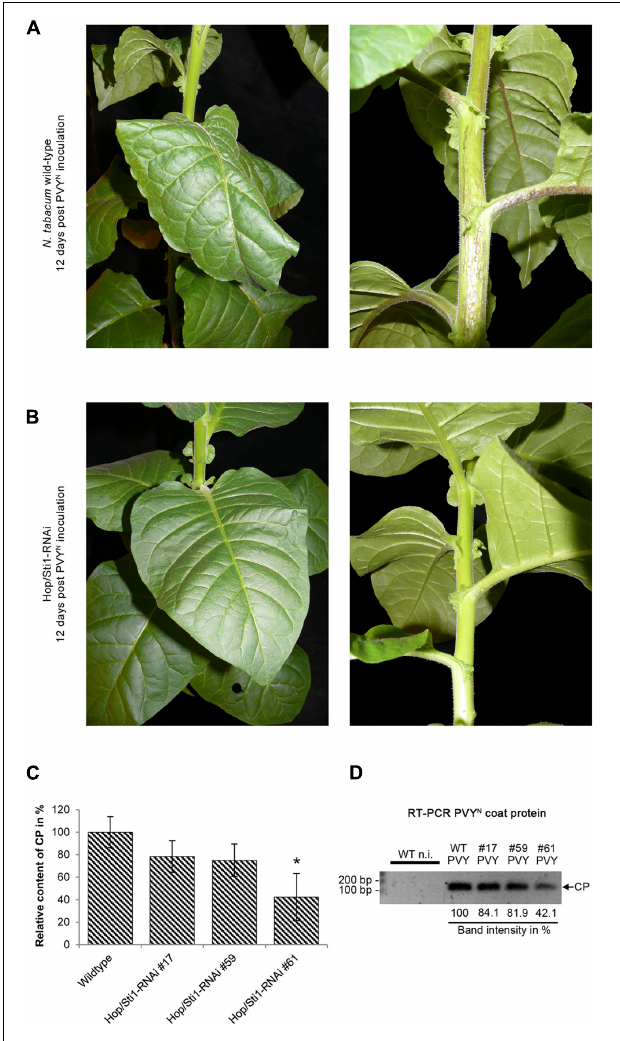
FIGURE 6 | Hop/Sti1-RNAi plants are PVY N -tolerant. (A) Nicotiana tabacum cv. Samsun NN wild-type plant infected by PVY N . Twelve days after mechanical inoculation, plants show severe infection symptoms including leaf deformation (left) and necrosis of stem and leaf veins (right). (B) Hop/Sti1-RNAi plants infected with PVY N . Transgenic plants look healthy and do not show typical disease symptoms 12 days after inoculation. (C) PVY-CP ELISA. PVY N titer was determined in infected wild-type and Hop/Sti1-RNAi plants. An asterisk indicates significance (Bonferroni-corrected student’s t -test, p -value: 1.89E– 02). Error bars represent the standard error. (D) Accumulation of viral RNA in infected wild-type and Hop/Sti1-RNAi plants. RT-PCR was used to amplify a 122-basepair fragment of the viral RNA encoding the coat protein (depicted by an arrow labeled CP). The amplicon could be detected in infected wild-type and transgenic plants both, but not in non-infected control plants. Values below depict the respective band intensities relative to the infected wild-type control.